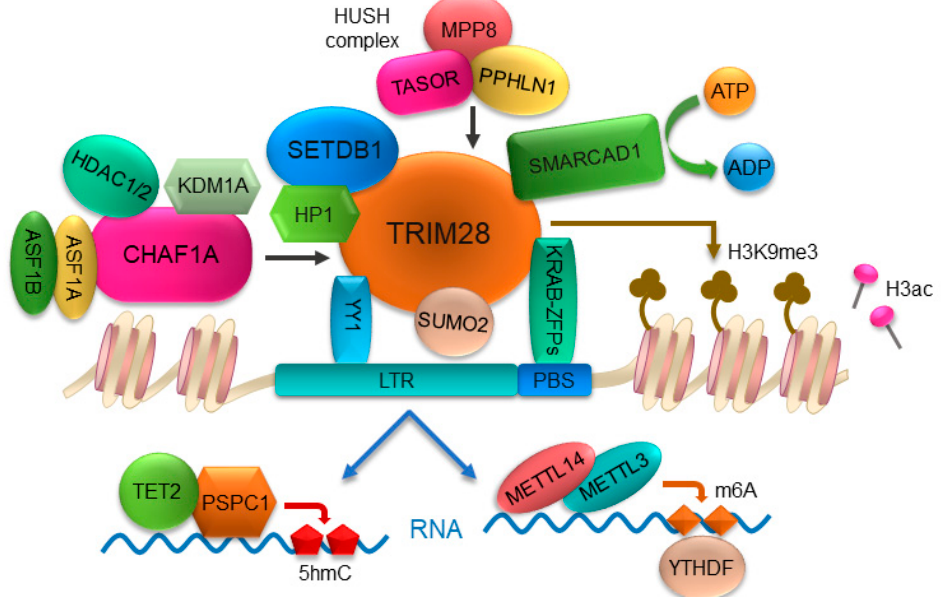
Figure 2. An overview model of ERVs silencing. ERVs are predominantly silenced by H3K9me3 through the canonical KRAB-ZFPs/TRIM28 pathway. KRAB-ZFPs bind to PBS region of ERVs and recruit TRIM28. Sumoylation of TRIM28 by SUMO2 enhances the recruitment of TRIM28 to ERVs. The ATPase activity of chromatin remodeler SMARCAD1 contributes to the occupancy of TRIM28 at ERVs. TRIM28 provides a scaffolding platform allowing for the recruitment of SETDB1, HP1, and HUSH complex, and the formation of macromolecular ensembles, which establish H3K9me3 in ERVs. Histone chaperone CHAF1A interacts with HP1, SETDB1, KDM1A, and HDAC1/2, modifying proviral chromatin with the repressive histone mark H3K9me3 and reducing the acquisition of active H3K4me3 and H3Ac marks. Histone chaperone isoforms ASF1A and ASF1B promote the lo- calization of CHAF1A to ERVs. In addition to transcription-based silencing, RNA-mediated regula- tion of ERVs, such as epigenetic modifications of ERV RNAs, also play a critical role in silencing of ERVs.